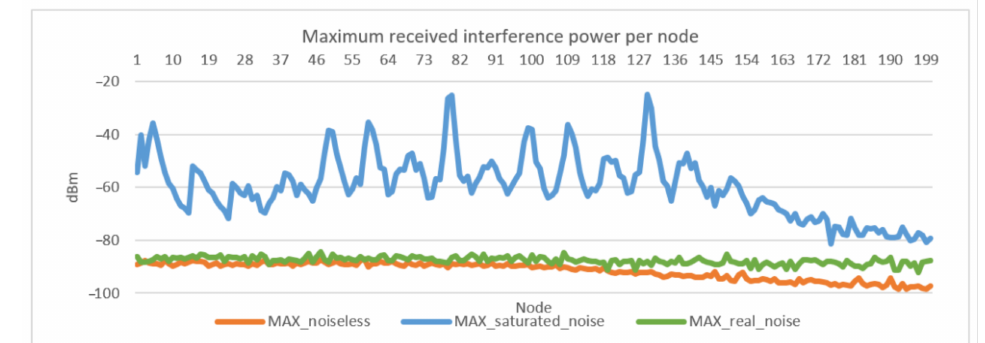
Figure 9. Power of interference received by each node, for noiseless, saturated, and real scenarios.